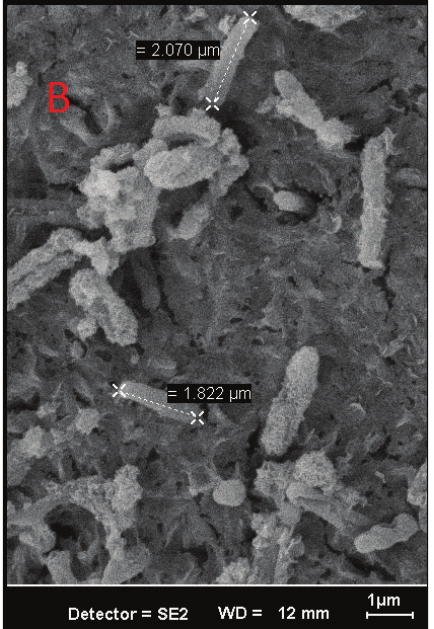
Figure 9: SEM images of the biofilms incubated at 37 ∘ C for 30 days for ATCC 7757